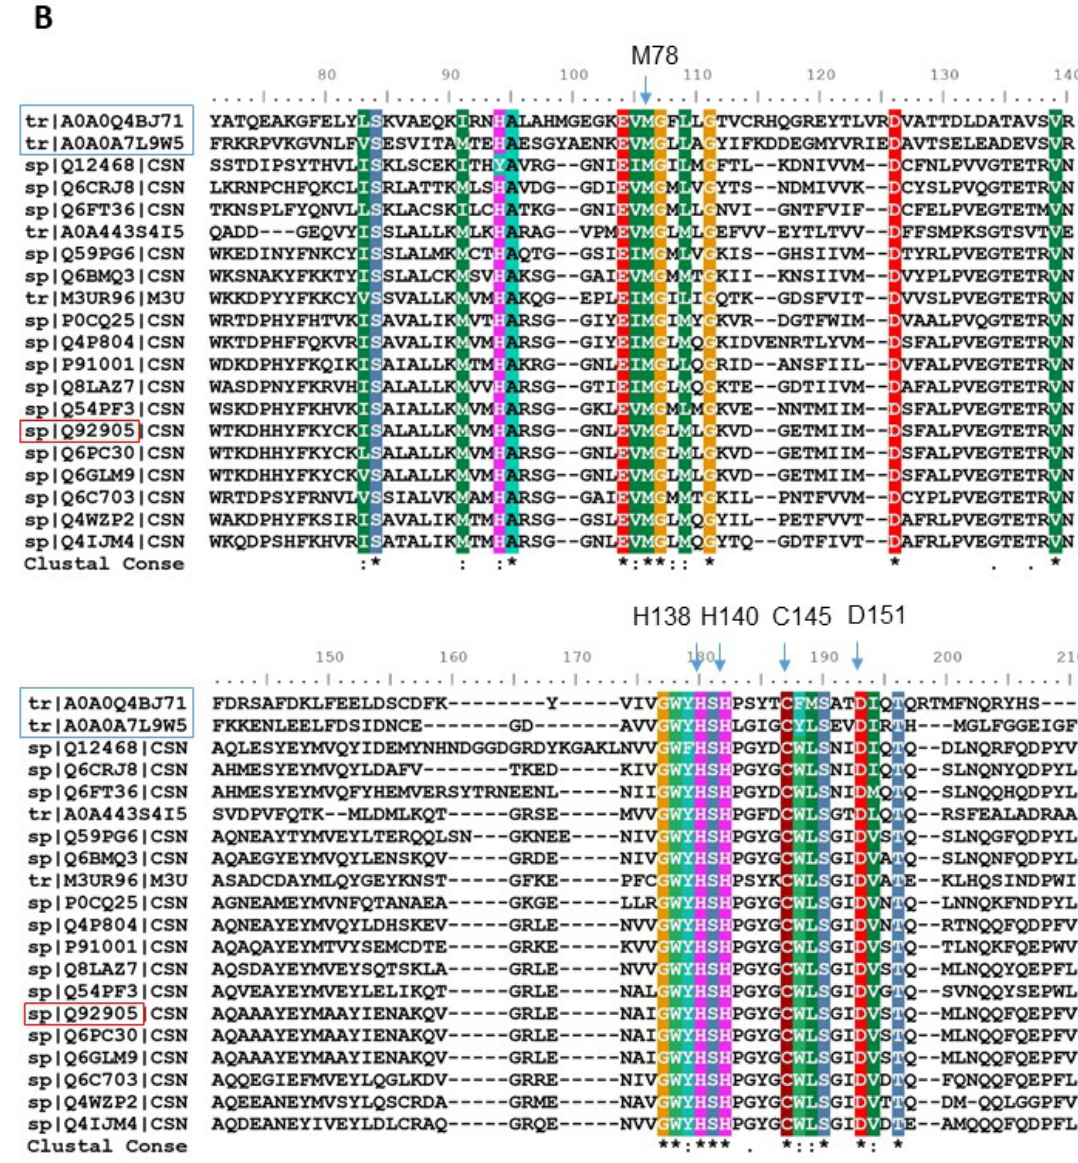
Figure 8. Proposed importance of Met78 in regulation of Jab1 function by MsrA. ( A ) Jab1 (blue ribbon) in complex with inhibitor (orange) revealing the close proximity of methionine 78 (M78) to the substrate binding cleft of the Zn 2+ metalloprotease active site. Stick diagram is used to indicate the inhibitor (CSN5i-3), residues that coordinate Zn 2+ (His138, His140 and D151) and other residues in the active site region (M78, T154, N158, W136 and C145). Crystal structure [PDB: 5JOG, PMID: 27774986] [46] was visualized using Chimeria v1.14 [PMID: 15264254] [47]. ( B ) Multiple amino acid sequence alignment of the central domain of representative Jab1 homologs selected from diverse organisms. Coloring and * or: indicates regions of 100% identity or similarity, respectively. Residues that coordinate Zn 2+ (His138, His140 and D151) and other residues in the active site region that may be susceptible to oxidation (M78 and C145) are indicated by down arrows. Protein identifier indicated on left with Homo sapiens denoted by a red box and Archaea indicated by blue boxes (see Table S1 for the complete listing of the proteins in the alignment).